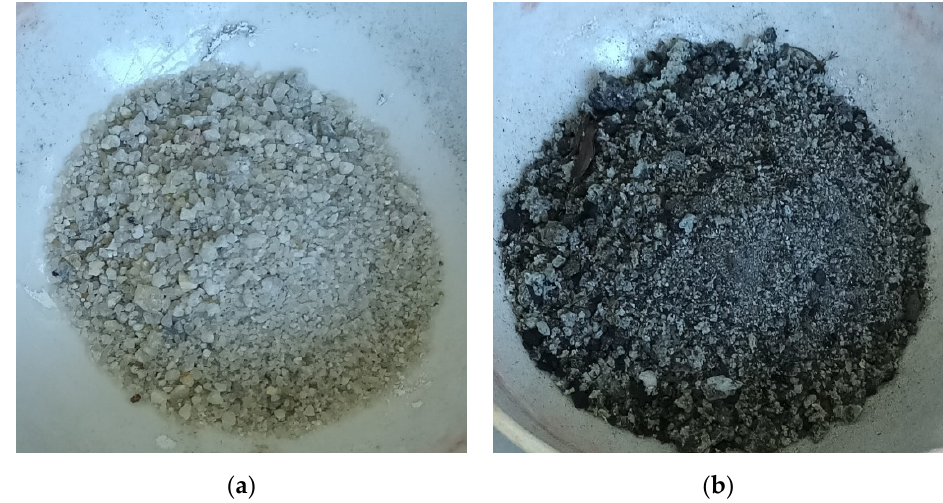
Figure 1. Natural sand and OPBC aggregates. ( a ) Natural sand aggregates. ( b ) OPBC aggregates. Table 4. Mix proportions of mortar mixtures in one